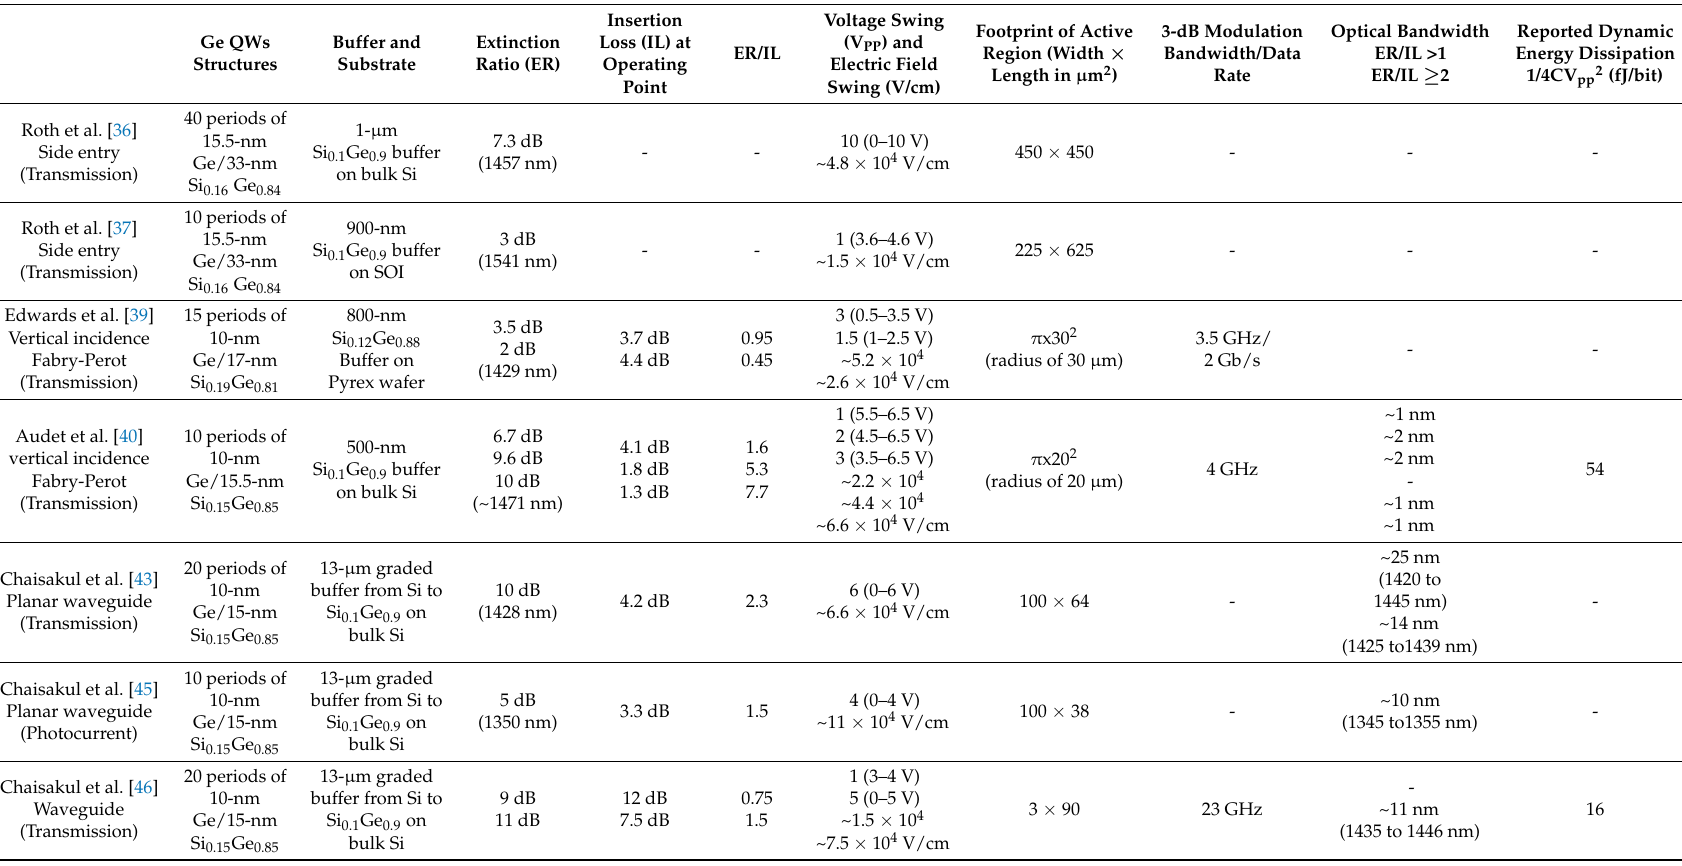
Table 1. Summary of performance matrix obtained from QCSE Ge/SiGe MQW optical modulators experimentally